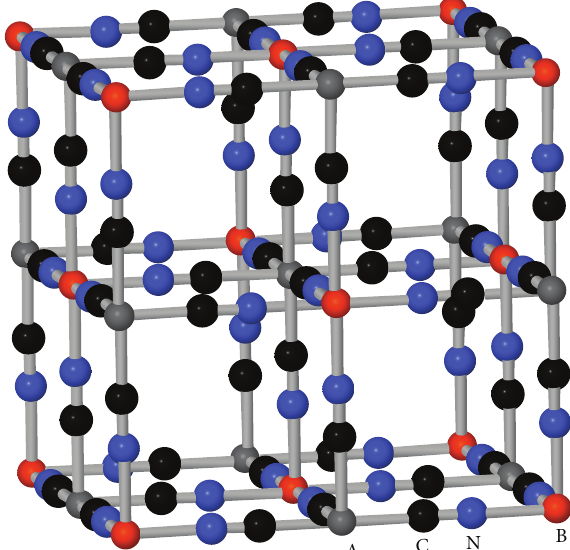
[ B ( CN ) ] ⋅𝑥 H 6 2 O. P q